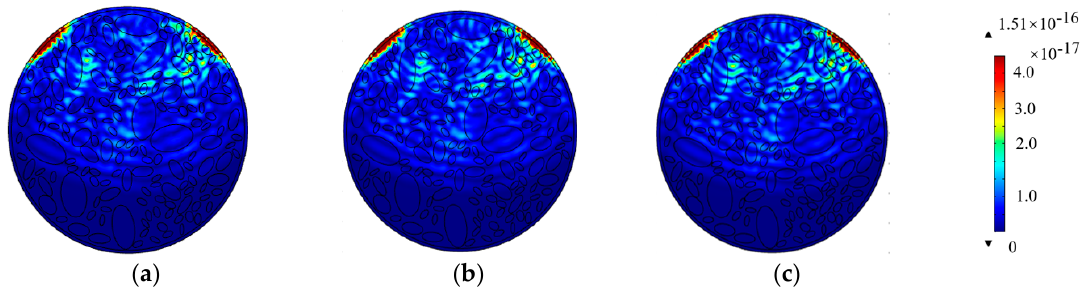
Figure 4. Comparison of the wave fields simulated with different mesh sizes ( a ) mesh size: 1.2 cm; ( b ) mesh size: 2.4 cm; ( c ) mesh size: 4.8 cm.